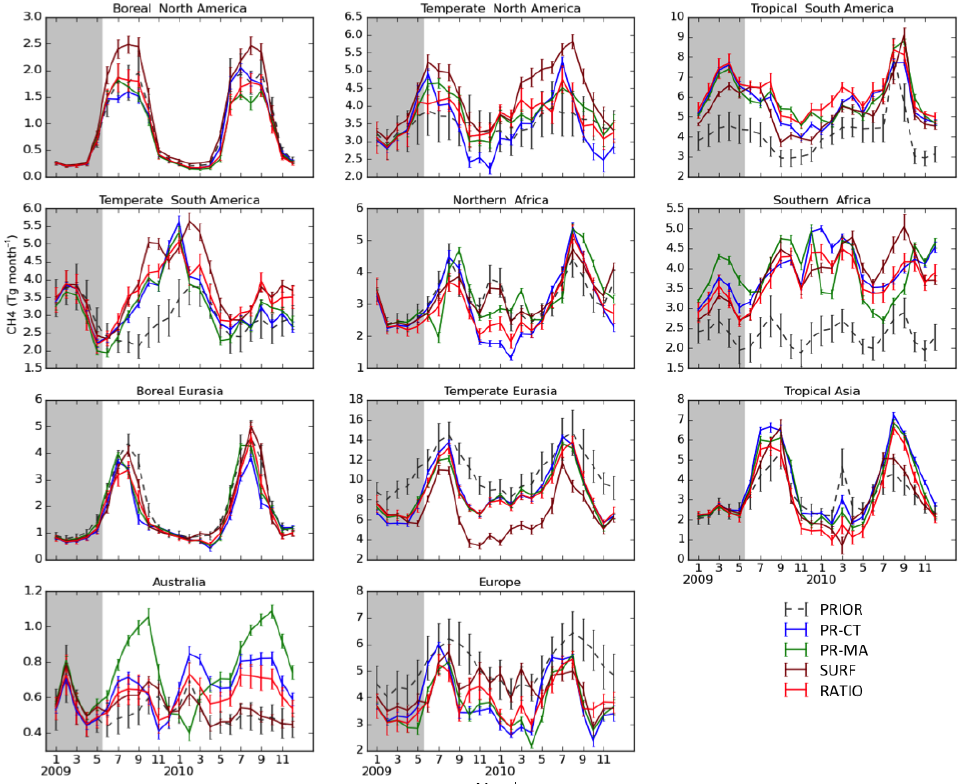
Figure 4. Monthly fluxes of CH 4 integrated over TransCom regions. The vertical lines represent a 1 σ uncertainty of the monthly fluxes. The gray region in each plot represents the period in which no measurements are assimilated.